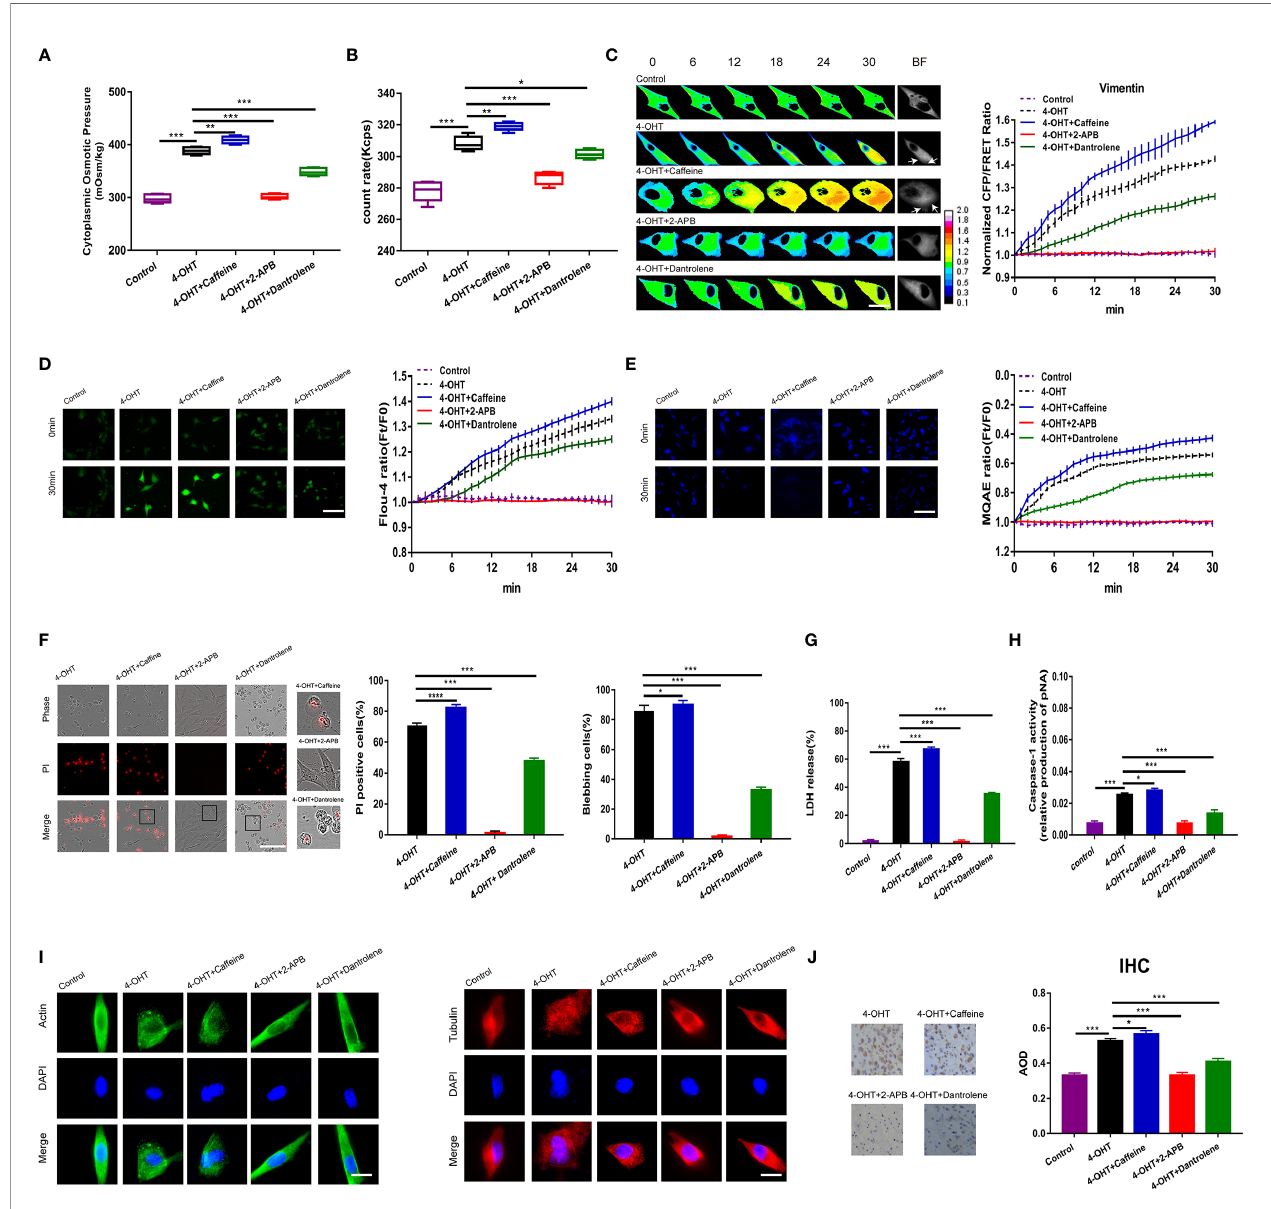
FIGURE 6 | Calcium ions released from the endoplasmic reticulum regulated pyroptosis. (A) The cytoplasmic OP values of U87 cells were measured using a freezing point osmometer under the isotonic control, 4-OHT treatment, and co-treatments of 4-OHT with caffeine (2 mM), 2-APB (100 m M), and dantrolene (20 m M). (B) The count rate of PNs in U87 cells. (C) Representative images and mean values of normalized CFP/FRET ratios of Vimentin tension under the different treatments. Arrows indicate the membrane blebbing regions. (D) Calcium imaging micrographs and traces of relative Fluo-4 fl uorescence intensity (Ft/F0) of cells. (E) Chloridion imaging micrographs and traces of relative MQAE fl uorescence intensity (Ft/F0) of cells. (F) Representative time ‑ lapse images of U87 cells subjected to different treatments. Cell membrane integrity was monitored by PI uptake (red fl uorescence). The bar charts represent percentage of cells with PI positivity and membrane blebbing. (G) LDH release and (H) caspase-1 activity of cells under the different treatments. (I) The control, 4-OHT, -caffeine, -2-APB, -dantrolene-treated U87 cell monolayers were stained for b -actin (FITC), a -tubulin (TRITC). The images were generated from the fl uorescence inverted microscope after immuno fl uorescence staining. (J) IHC analysis of caspase-1 expression in brain section of the sepsis mouse models. The cytoplasm was stained with the caspase-1 antibody (brown). Semiquantitative analysis of the IHC staining by AOD among the groups. Mean of ≥ 3 experiments ± SEM. Values marked with asterisks are signi fi cantly different, as determined using a t